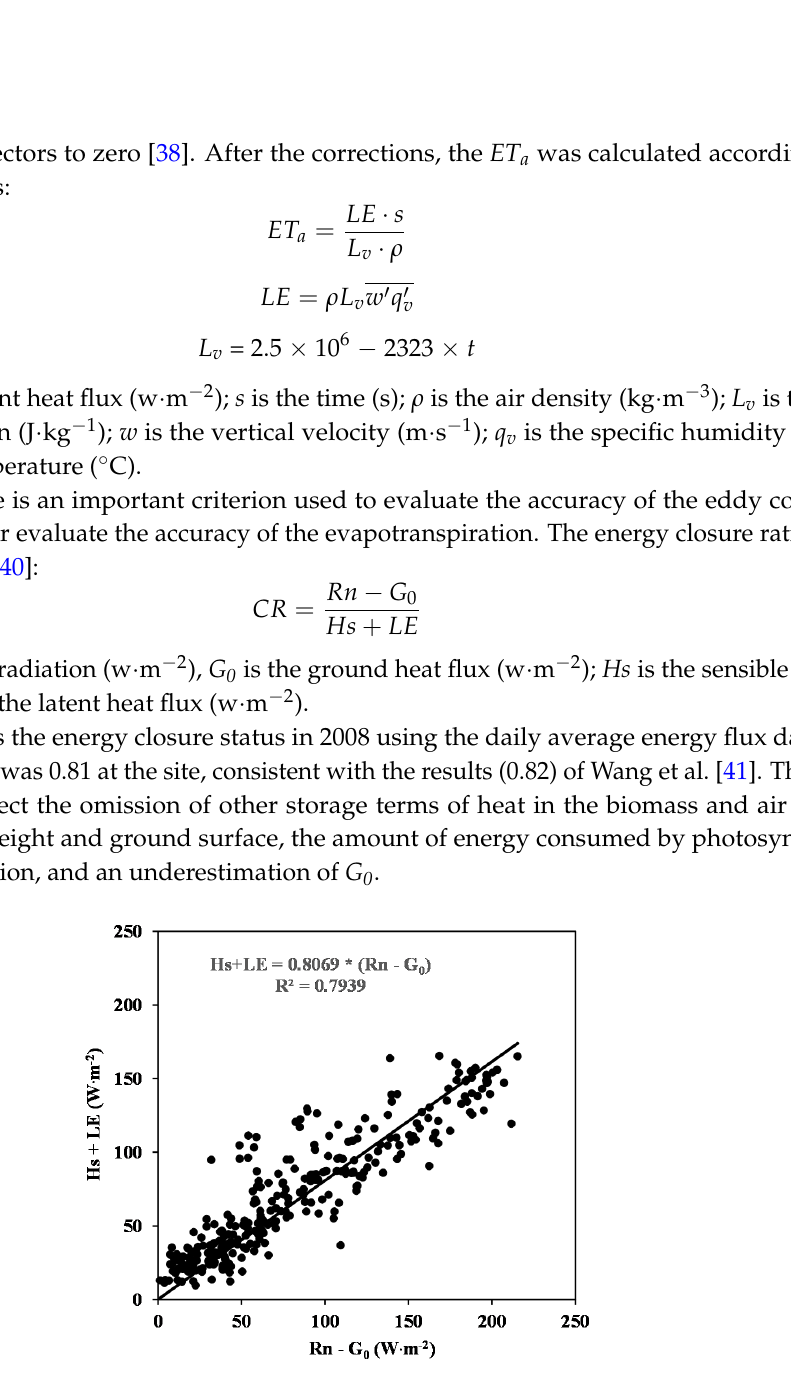
Figure 2. Energy closure status using the daily average energy flux data at the Yingke site.